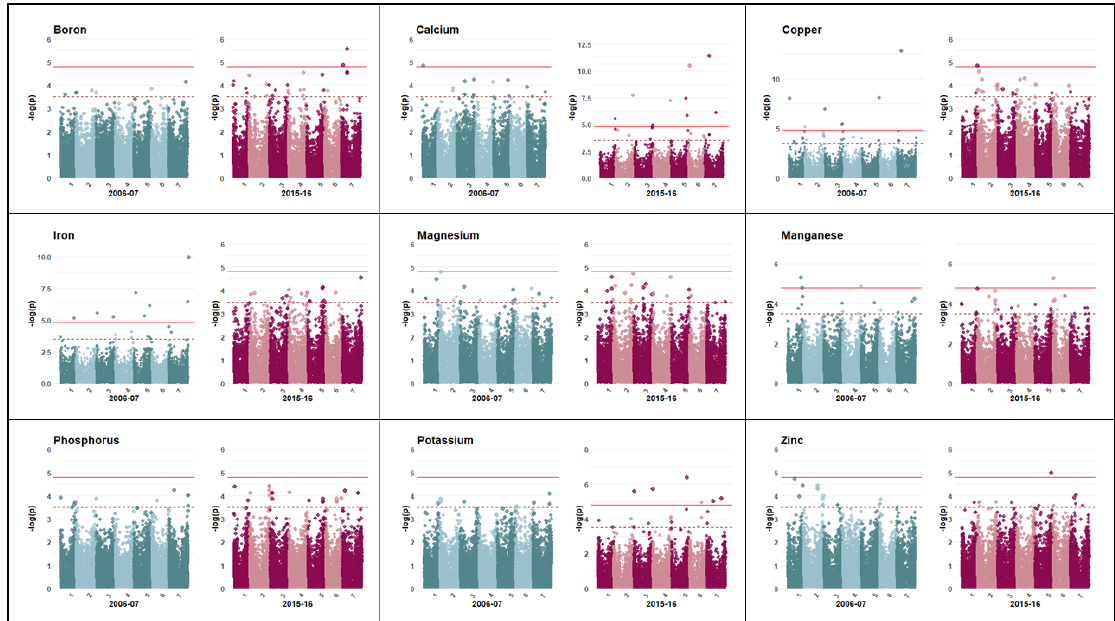
Figure 3. Manhattan plots for the genome wide association study, utilizing the FarmCPU GAPIT model, of seed mineral nutrient accumulation in the WBDC. The − log( p -value) > 4.79 threshold is indicated by a solid red line. The dashed line is representative of an initial lenient − log( p -value) > 3.5 cutoff.